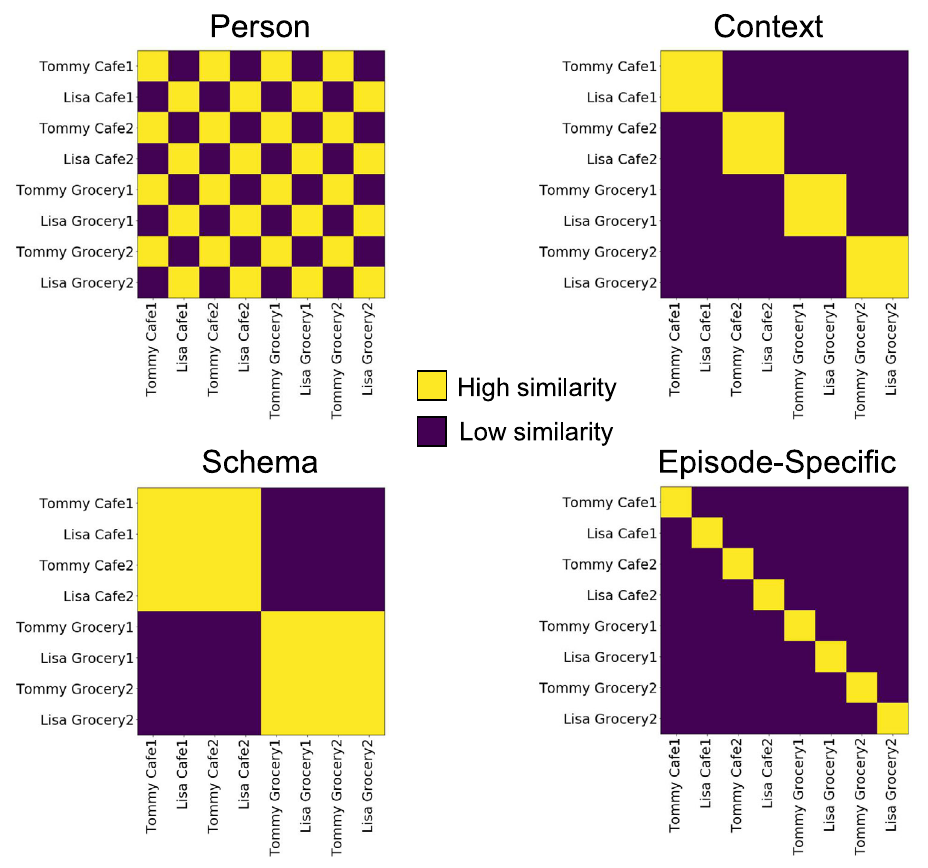
Fig.2|Modelmatricesbasedonhypothesizedrepresentationalpro fi les. Event- by-event correlation matrices resulting from pattern similarity analyses were